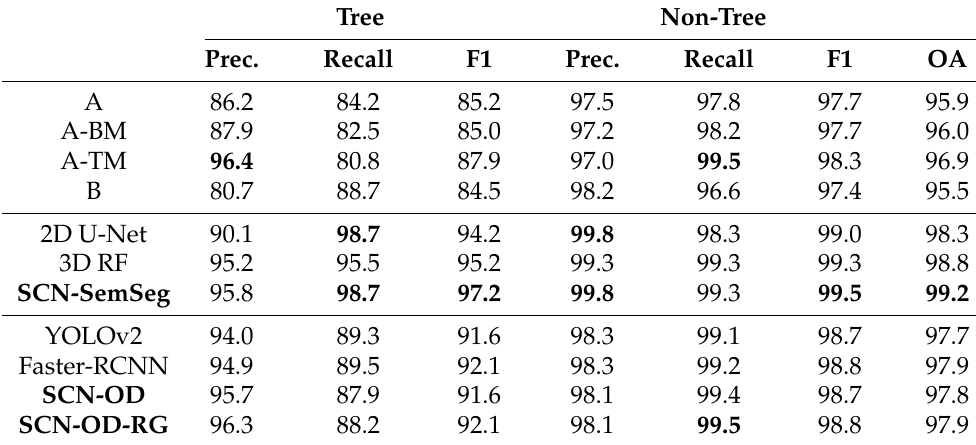
Table 4. Tree canopy cover accuracy in